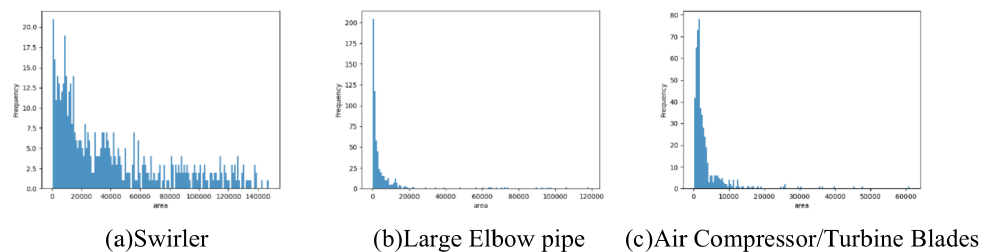
Figure 5. The damaged area of the eddy current device is relatively large, the larger part is less than 50,000, and the larger part is more evenly distributed. Most of the damaged areas of the large elbow pipe dataset are less than 10,000, and all of them are below 20,000. Most of the damaged areas of the blade datasets are less than 10,000, but the distribution is smoother than that of the large elbow pipe.